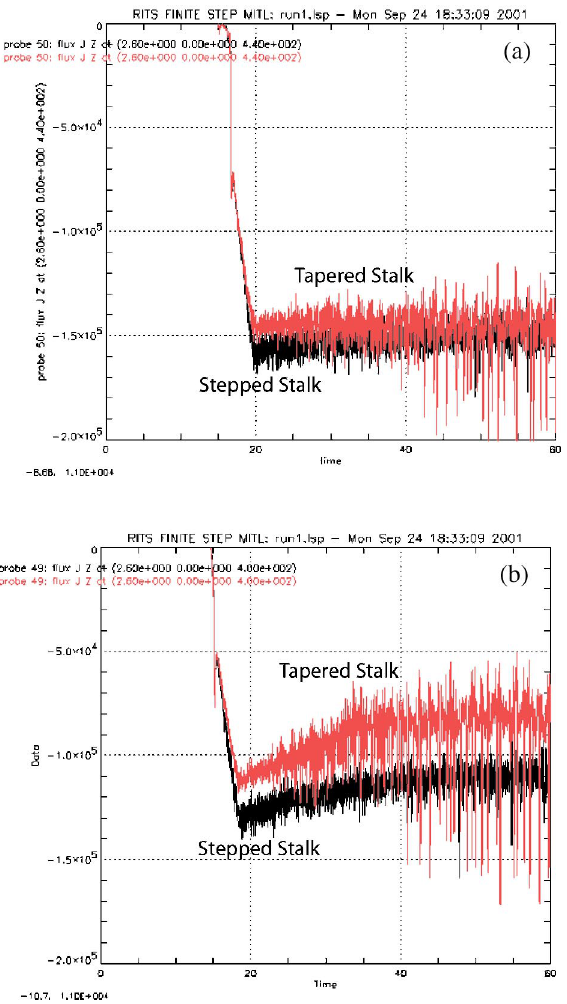
FIG. 17. (Color) Output of stepped and tapered RITS adders (a) total current, (b) sheath current.